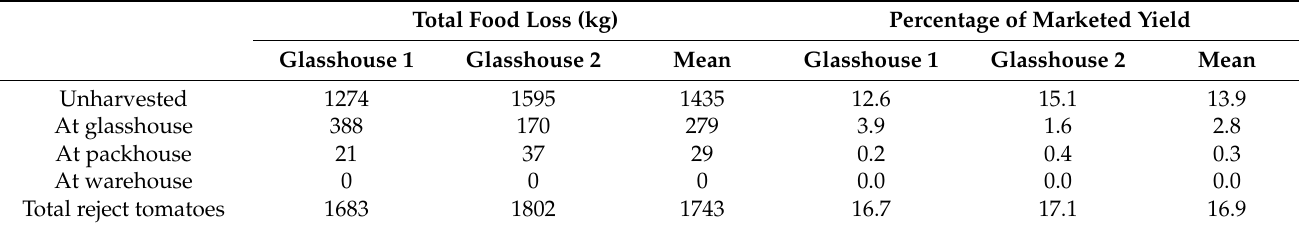
Table 1. Total food loss and percentage of marketed yield at glasshouse, packhouse and sales warehouse for the audited harvest